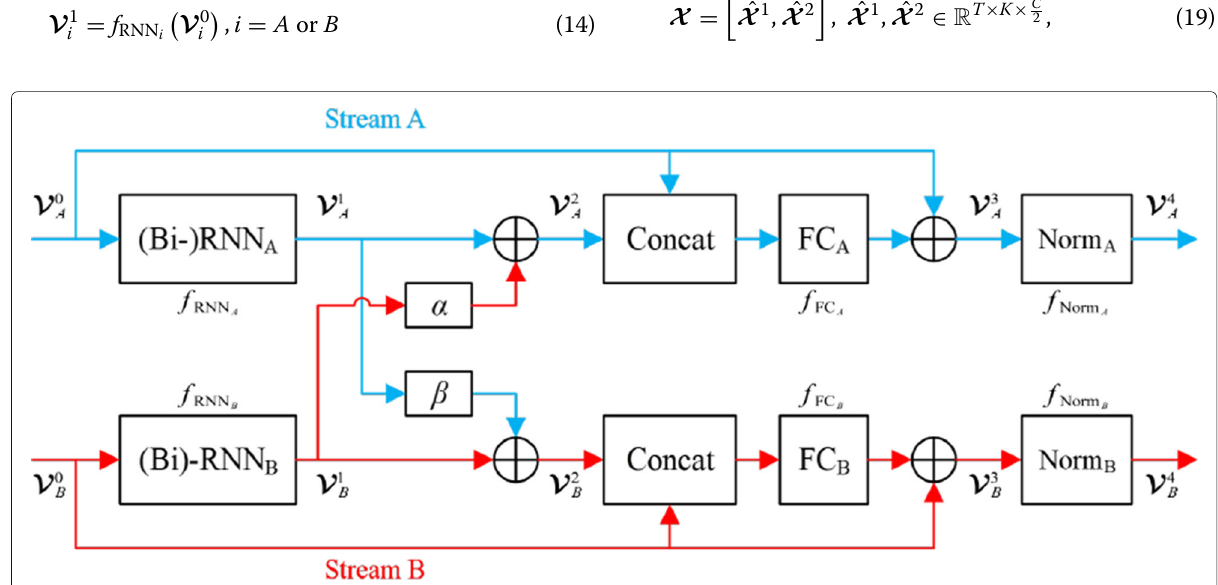
Fig. 5 The structure of the DSRNN block. The blue line and the red line represent stream A and stream B